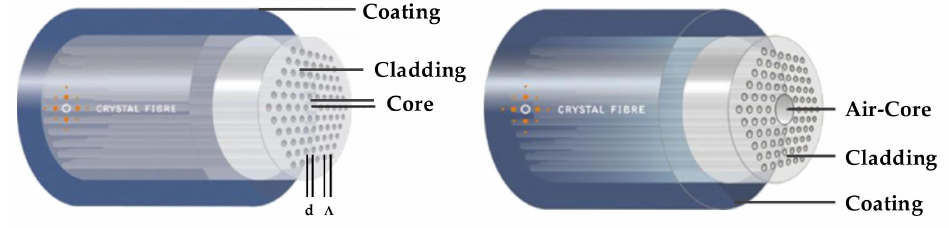
Figure 1. Microstructural arrangement of solid-core PCFs and hollow-core PCFs [7]. Based on the different light-guiding mechanisms in solid-core and hollow-core